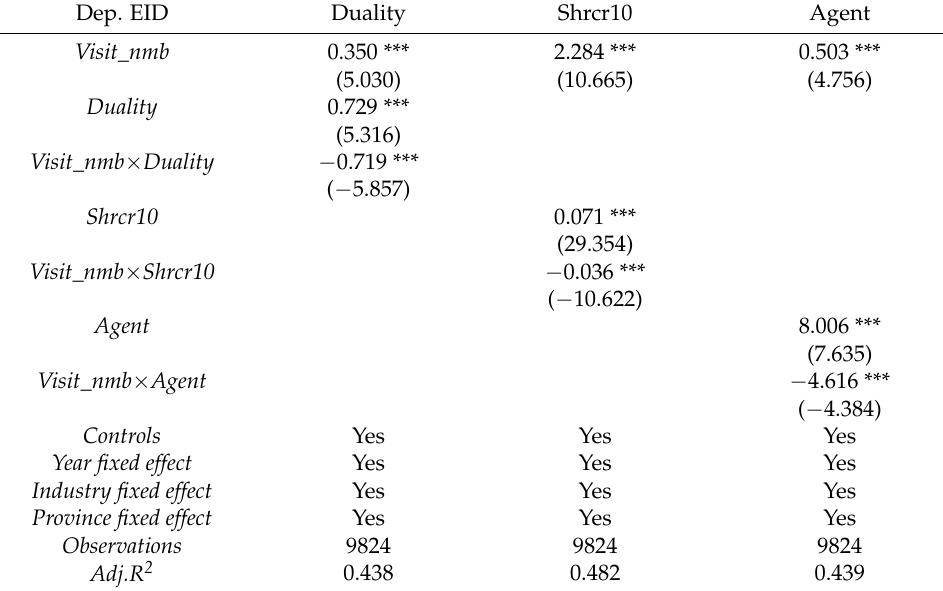
Panel B: The moderating effect of microcosmic influencing